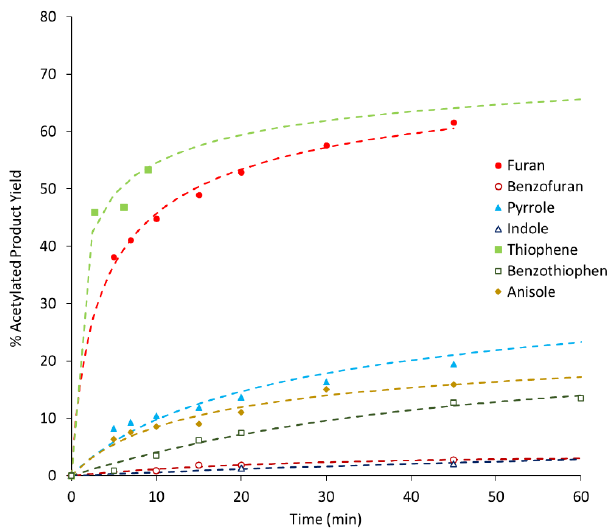
Figure 3. Product yield as a function of reaction time using BEA-D-AT as the catalyst (the dashed curves represent calculated values resulting from the application of the kinetic model).